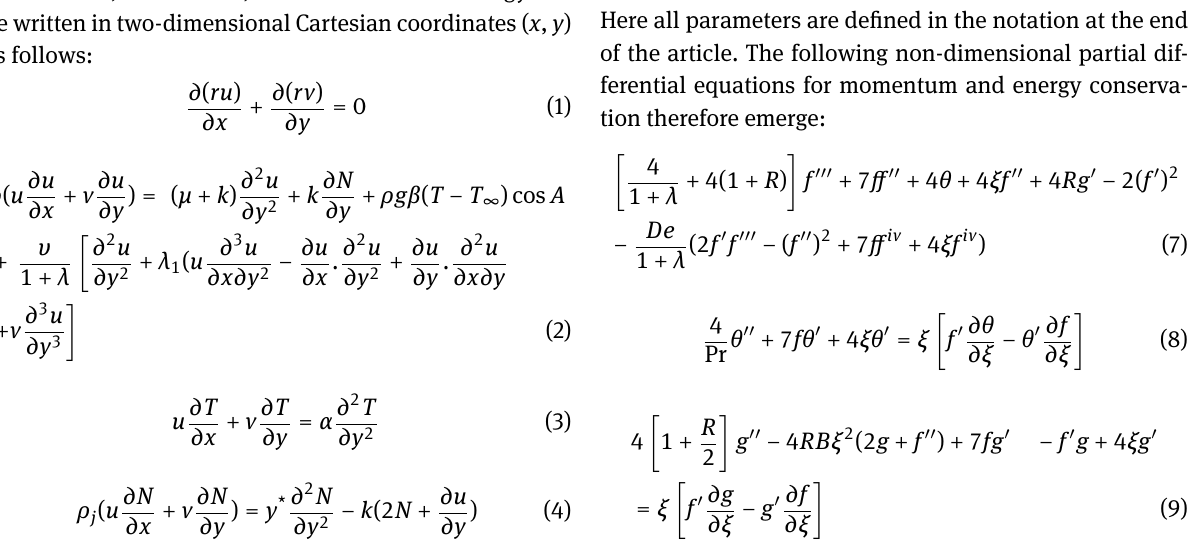
cropolar fluid (polymeric liquid) from a vertical isother- mal solid cone, as shown in Fig. 1. Both cone and liquid are maintained initially at the same temperature. Fourier’s law is assumed for heat conduction i.e. thermal relaxation effects are negated. Thermal stratification and dispersion are also neglected as is viscous heating. The flow is lam- inar, steady-state and the cone surface isothermal. These conditions correspond to steady polymeric convection in external boundary layer flow development on an axisym- metric cone geometry. Instantaneously the cone surface is raised to a temperature T w > T ∞ , where the latter (ambient) temperature of the polymeric fluid is maintained as con- stant. The x -coordinate is measured along the slant sur- face of the cone from the origin (at the vertex) and the y - coordinate is directed normal to the cone surface. The cone has a semi-vertex angle of A